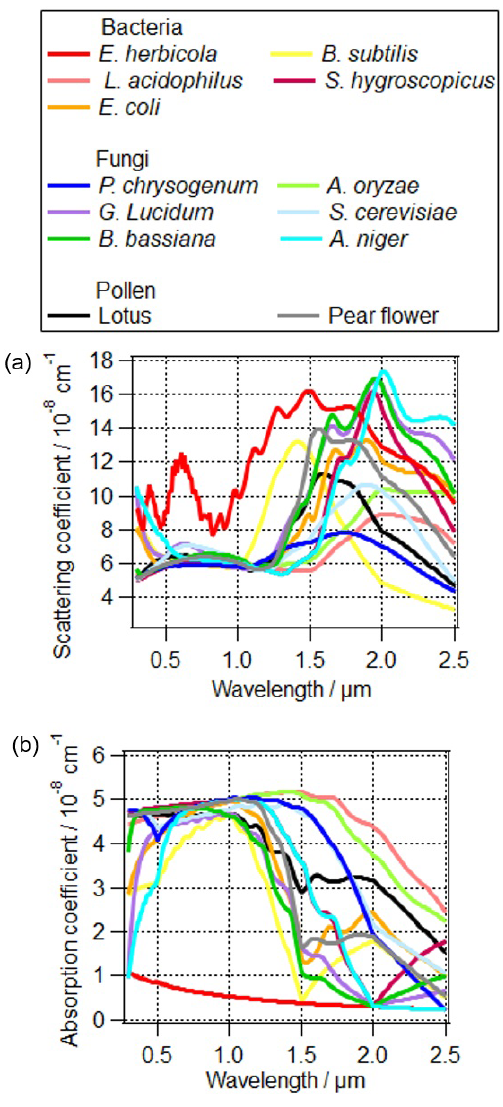
Figure 6. The influence of different PBAPs on (a) the scattering co- efficient and (b) absorption coefficient of total particles. The refrac- tive indices are based on the measurements by Arakawa et al. (2003) and Hu et al.